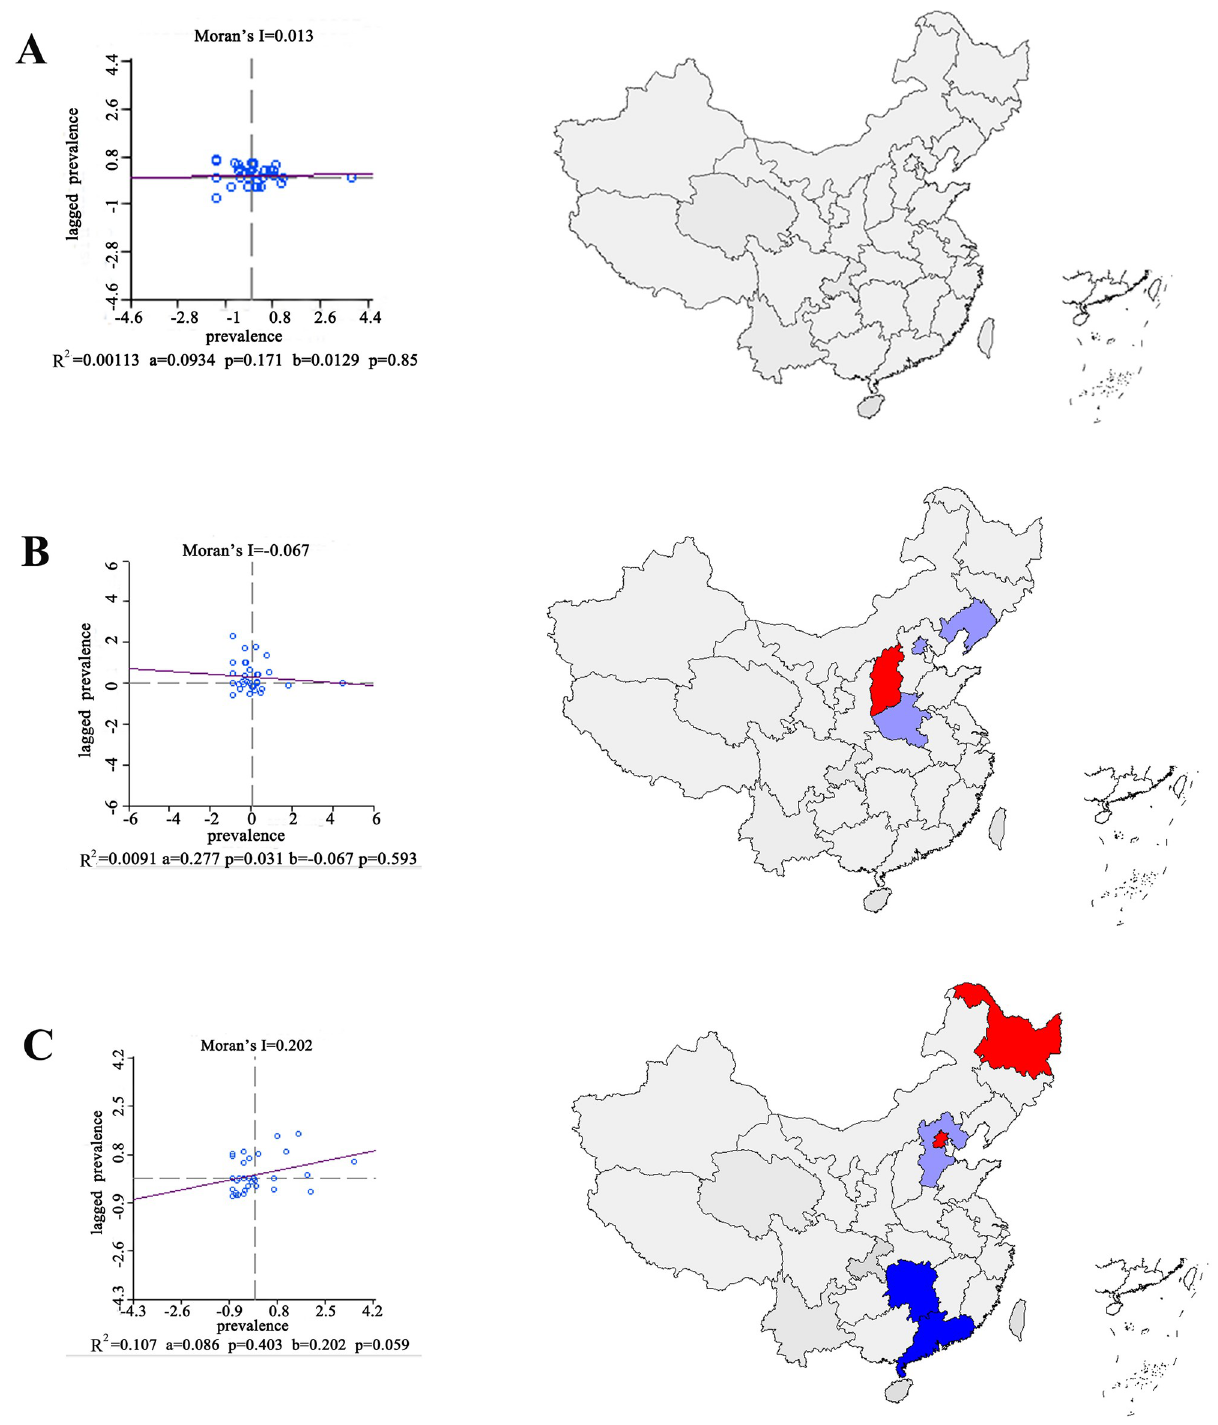
Fig 2. The result of local spatial autocorrelation of multimorbidity pattern. (The source of map: http://bzdt.ch.mnr.gov.cn/browse.html?picId=% 224o28b0625501ad13015501ad2bfc0240%22). A, the result of local spatial autocorrelation of [Asthma / Chronic lung diseases]; B, the result of local spatial autocorrelation of [Arthritis of rheumatism, Asthma / Chronic lung diseases]; C, the result of local spatial autocorrelation of [Dyslipidemia, Hypertension, Arthritis or rheumatism / Heart attack].